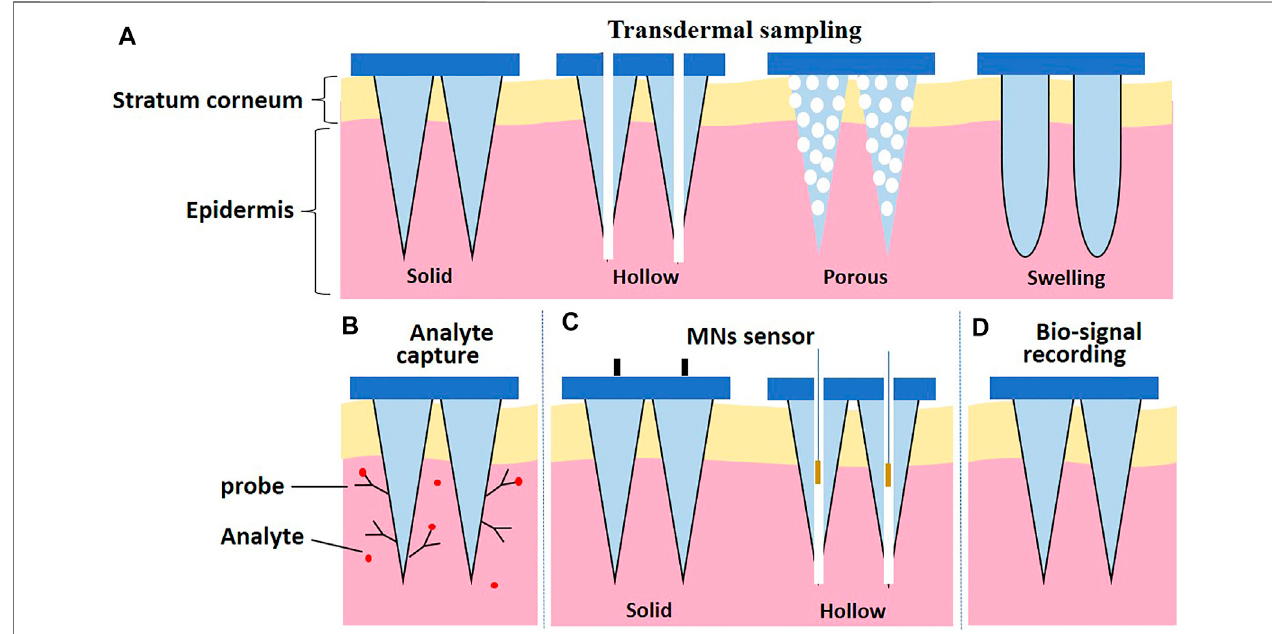
FIGURE 1| Schematic illustration ofcategories according tothe design strategies of MNs. (A) Transdermal sampling. (B) Biomarker capture. (C) MNs sensor. (D) Bio-signal recording.